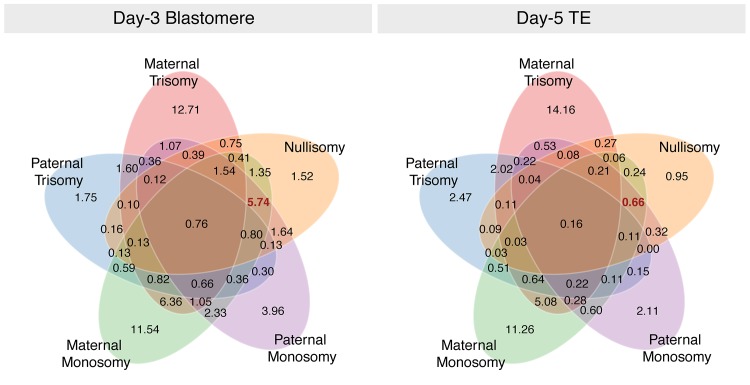
Venn diagram demonstrating that multiple forms of aneuploidy commonly co-occur within individual day-3 blastomeres.Numbers represent percent of the total sample. Complex aneuploidies, especially those involving multiple forms of chromosome loss (highlighted in red) are common at day 3, but rare at day 5 of development. Isolated errors, in contrast, are relatively viable through blastocyst formation.